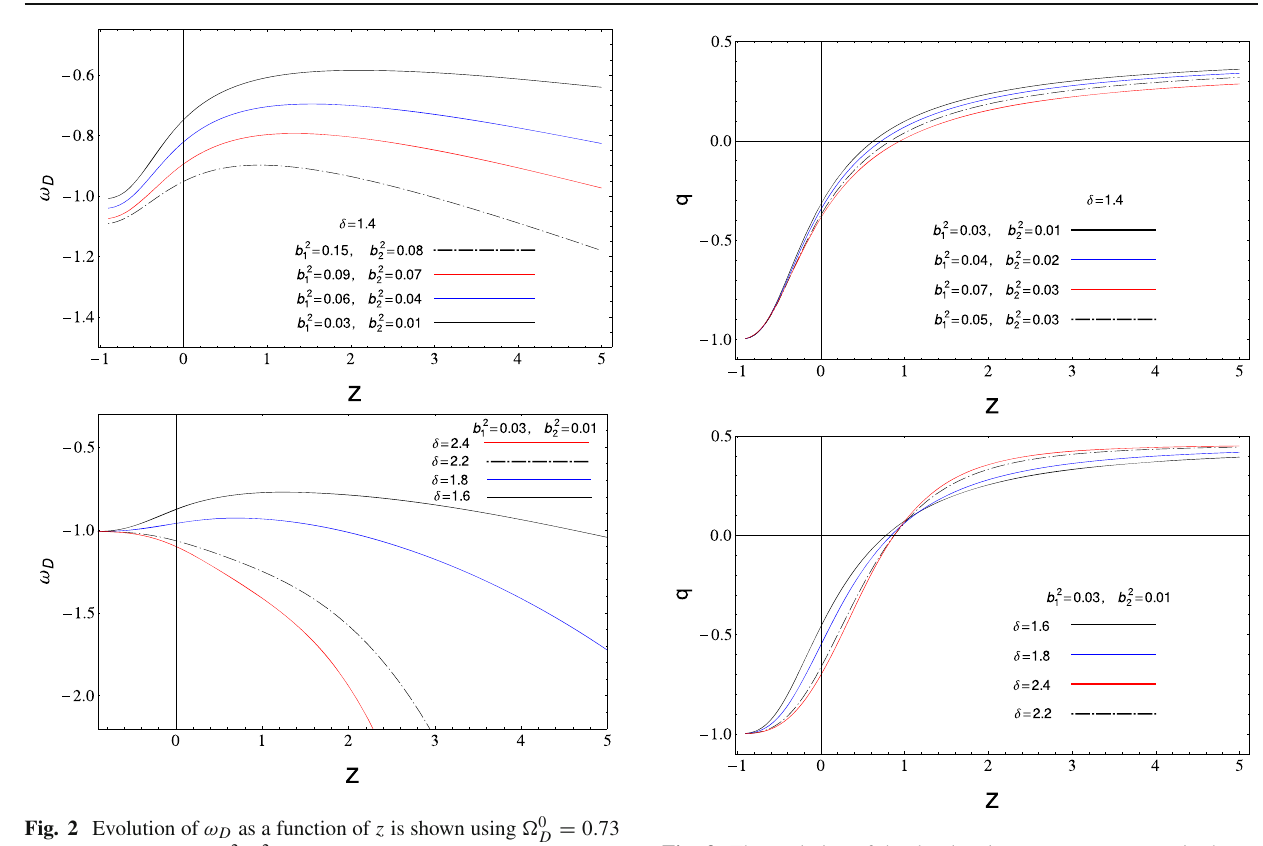
, b 2 and δ , as indicated in each 1 2